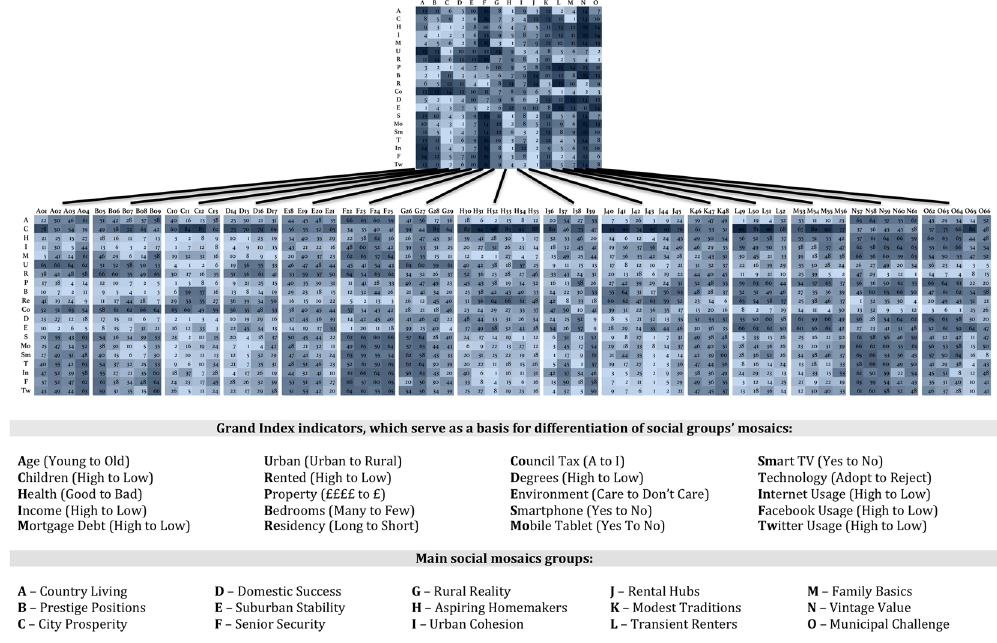
Figure 1. Structure of the Experian Mosaic Public Sector